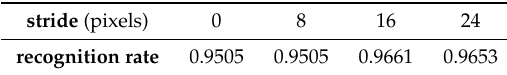
Table 6. The recognition rate versus the stride.